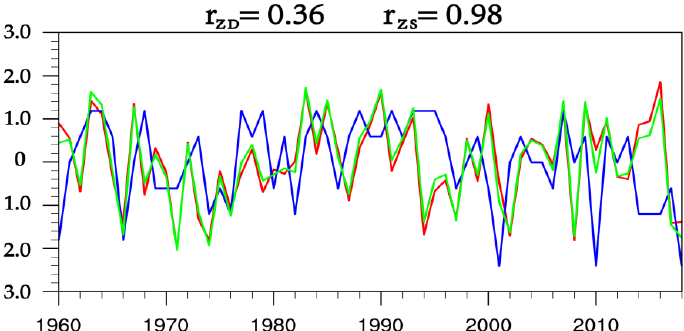
Figure 2. Red line: intensity; blue line: days; green line: accumulated temperature. r ZD : correlation coefficient between accumulated temperature and days, r ZS : correlation coefficient between accumulated temperature and intensity.